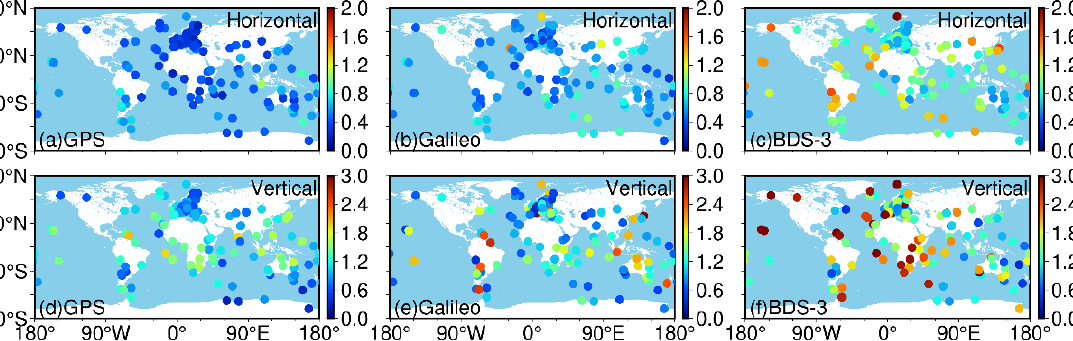
Figure 9. Geographical distribution of the median RMS of static PPP for the selected 143 worldwide MGEX tracking stations over a month period (September 2022) using three single systems. Table 4. The mean RMS (unit: cm) of the different latitudes for static PPP.